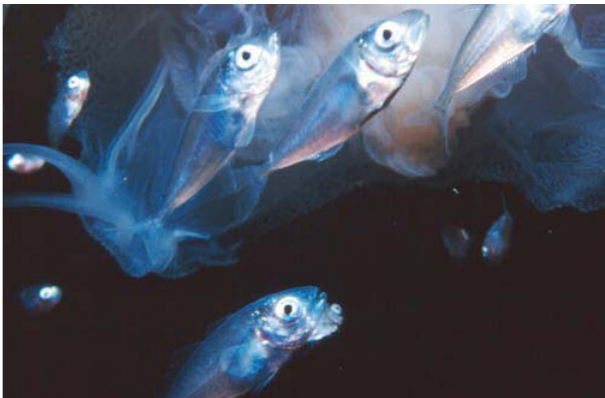
Fig. 2. Juvenile carangids and other fishes tend to stay close to a jellyfish’s umbrella or among its tentacles while frightened.